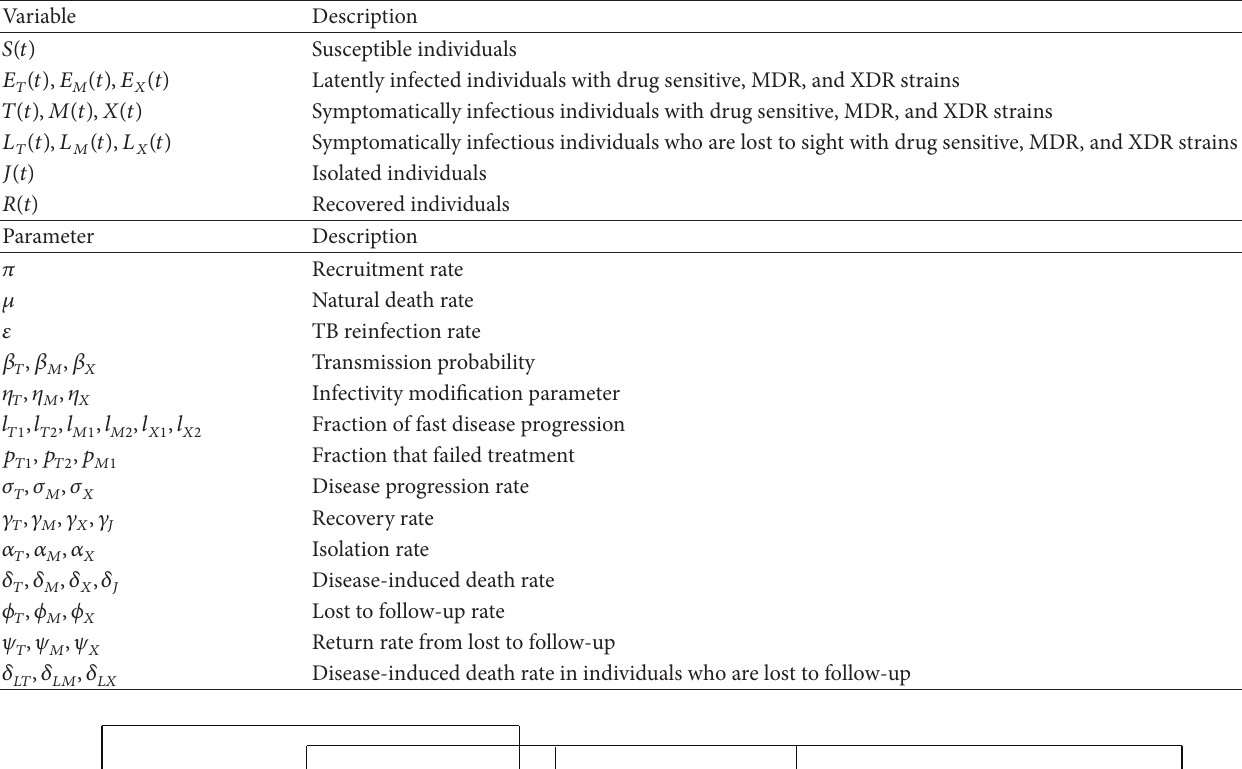
Table 1: Variables and parameters description of model (2).